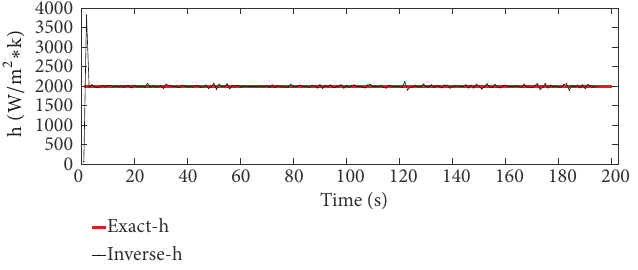
Figure 13: The heat transfer coefficient of the measuring point at the boundary 𝐿 = 0.008𝑚 .